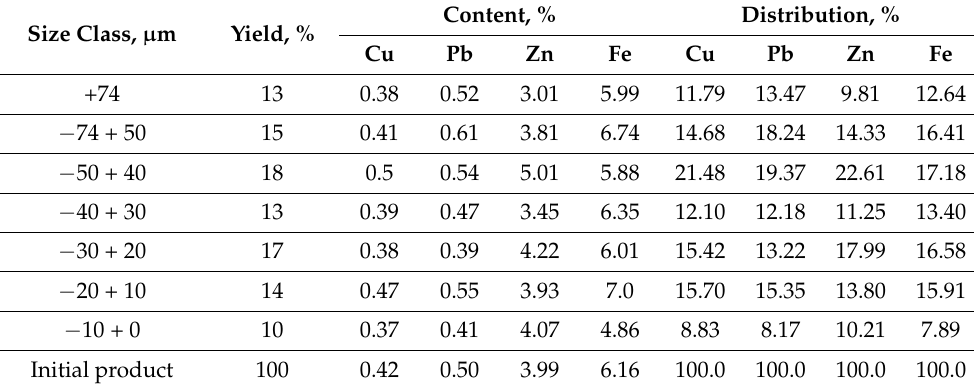
Table 1. Granulometric composition of crushed Cu-Pb-Zn-Fe polymetallic